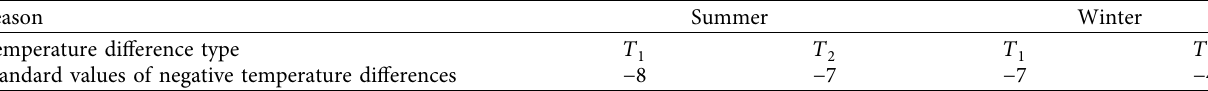
Table 6: Standard values of negative gradient temperature differences in single tube ( ° C).